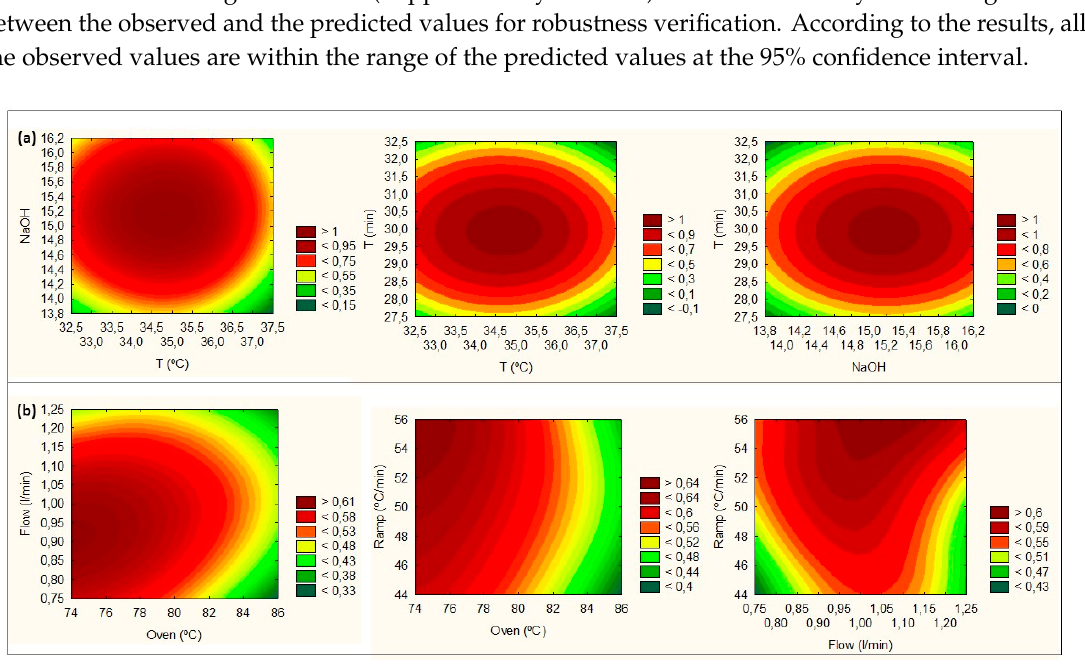
Table 2. Method control results.